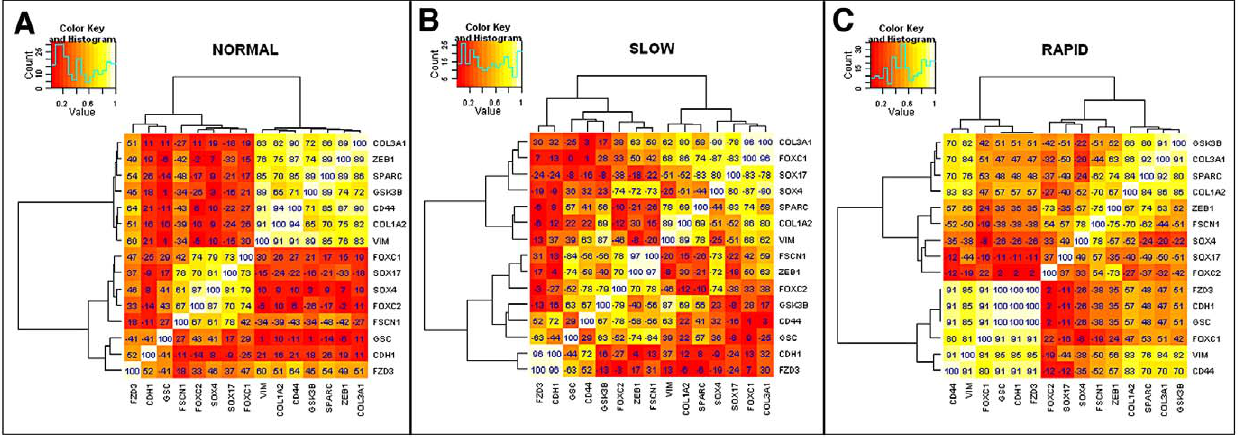
Figure 2. Correlations are shown between EMT-related genes in normal, slow IPF, and rapid IPF lung biopsies. The dCT values were clustered using the absolute value of correlation coefficients (distance measure) using hierarchical clustering to show the genes that are strongly related at each stage (NORMAL, SLOW and RAPID). Lighter colors represent greater correlation between genes. The larger the value indicated, the stronger the correlation. Negative values indicate a negative correlation.